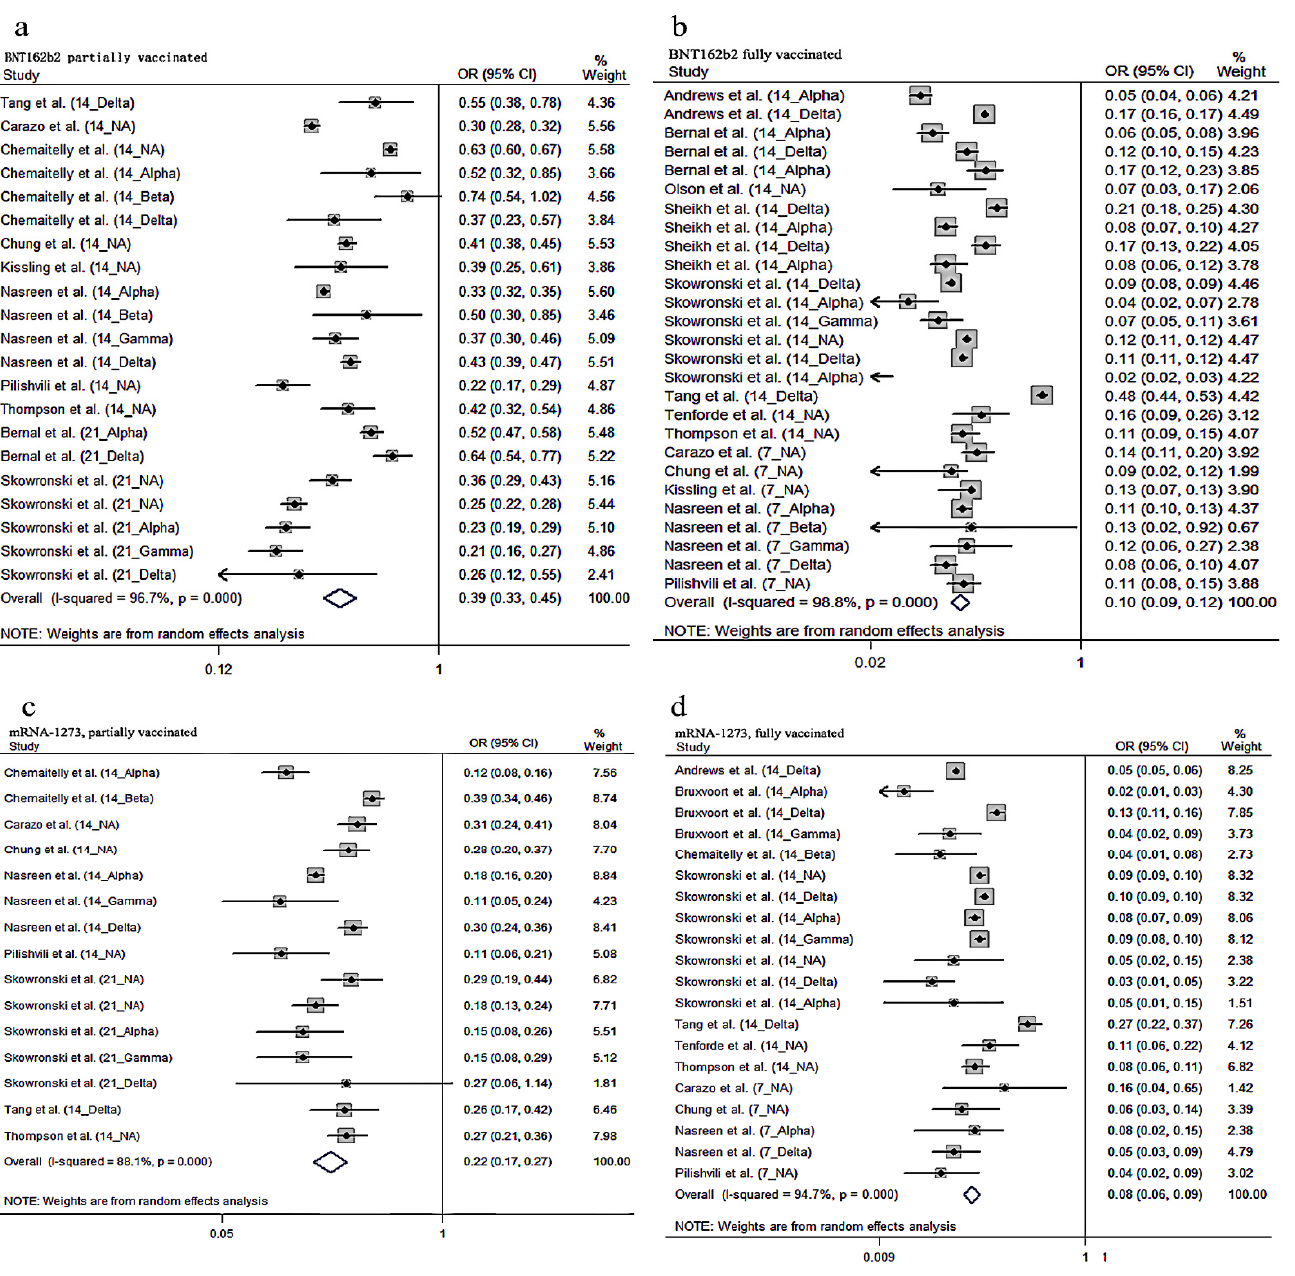
Figure 2. Forest plot odds ratio (OR) against COVID-19 infection ( a ): OR with 95% confidence intervals (CI) against COVID-19 infection (partially vaccinated BNT162b2); ( b ): OR with 95% confidence intervals (CI) against COVID-19 infection (fully vaccinated BNT162b2); ( c ): OR with 95% confidence intervals (CI) against COVID-19 infection (partially vaccinated mRNA-1273); ( d ): OR with 95% confidence intervals (CI) against COVID-19 infection (fully vaccinated mRNA-1273).